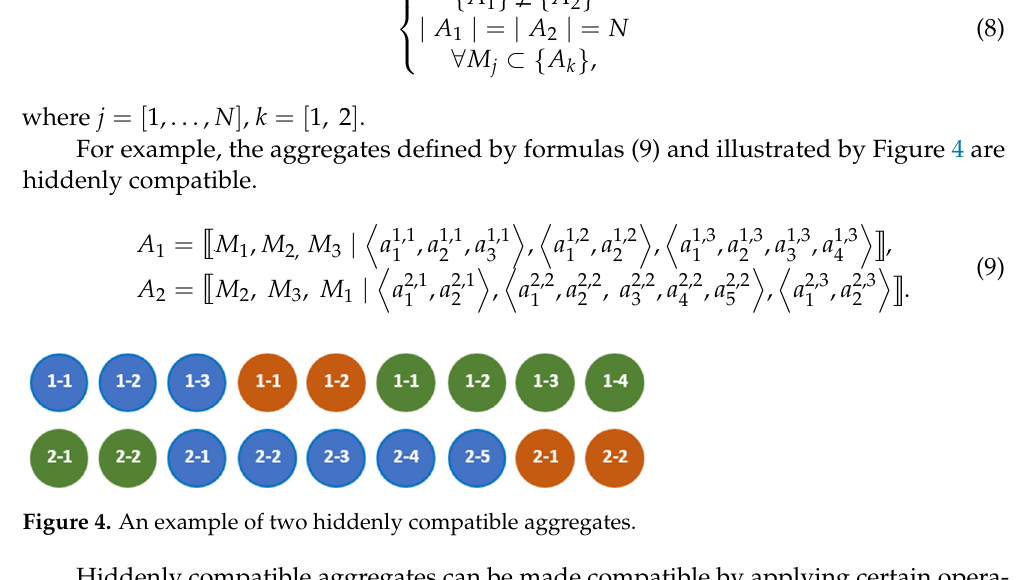
Figure 3. An example of two incompatible aggregates.